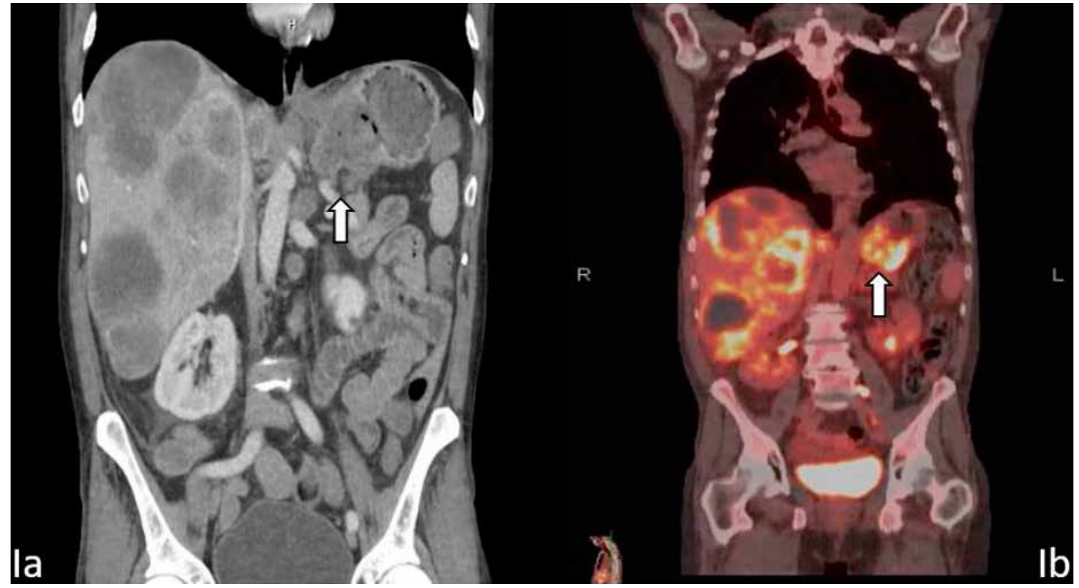
esophagus.Figure 1: (a) CT demonstrating gastric mass in the lesser curvature (arrow) with diffuse hepatic metastases. (b) PET scan with 6.5 cm hypermetabolic gastric (Arrow) and no additional sources for a primary tumor. Diffuse hepatic metastases again